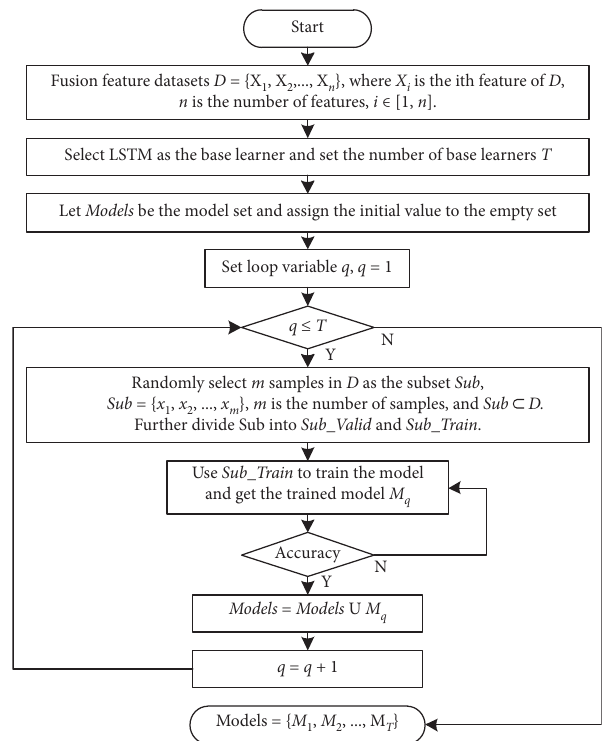
Figure 5: The flow chart of model training.